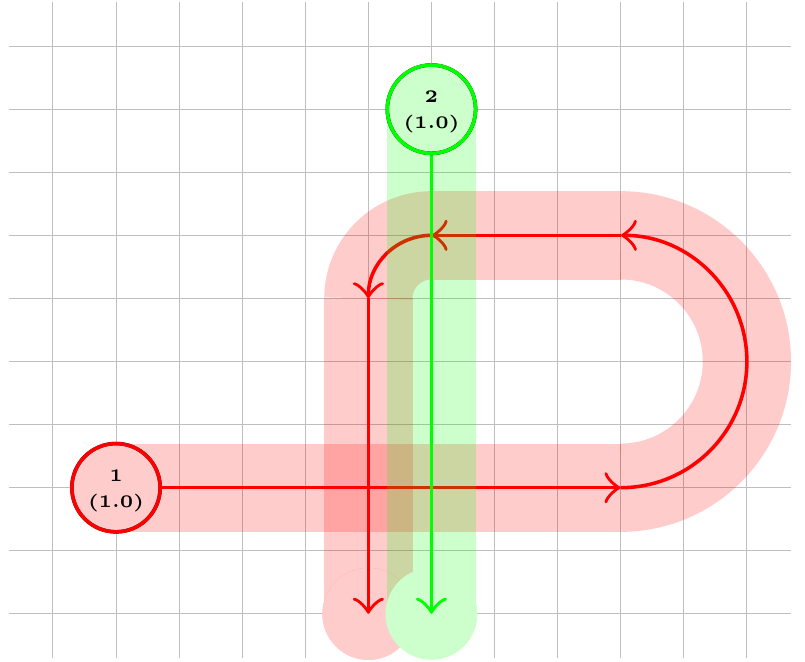
Figure 4. Counterexample instance for constructive